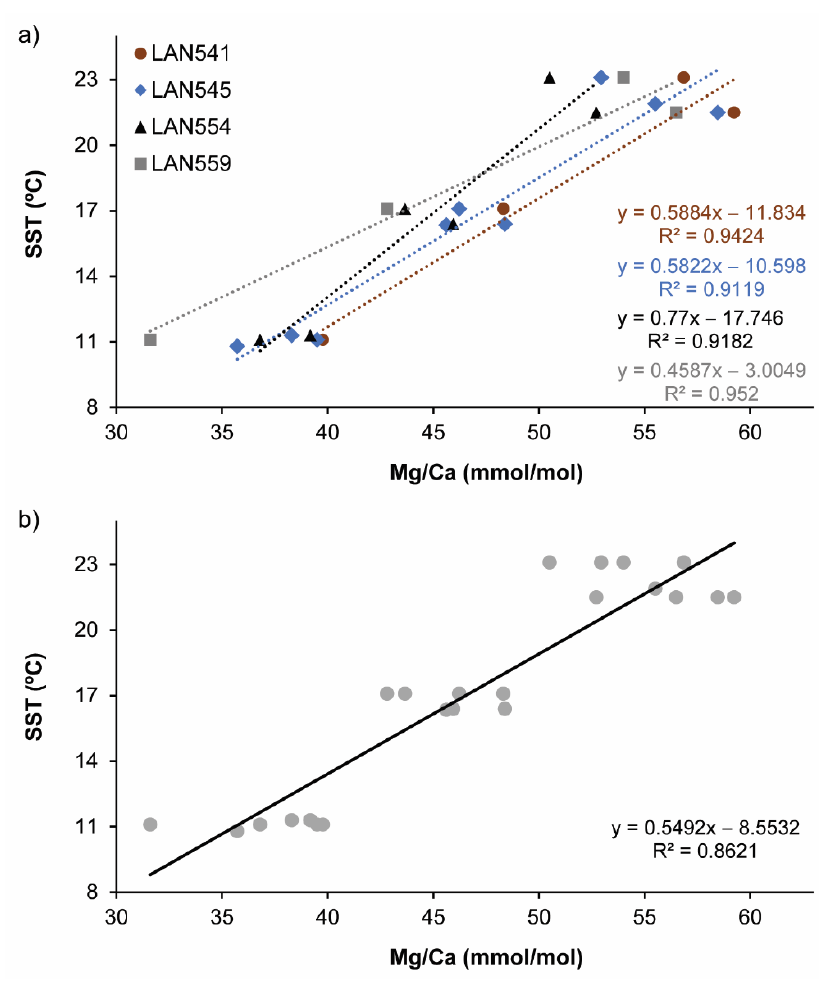
Figure 9. ( a ) Measured minimum, average, and maximum Mg/Ca ratios for each specimen in relation to the minimum, average, and maximum of instrumentally measured seawater temperature. Regression lines and equations, and the correlations, were calculated individually for each sample. ( b ) Measured minimum, average, and maximum Mg/Ca ratios for all specimens in relation to the minimum, average, and maximum of instrumental seawater temperature. The regression lines and equations, and the correlation, were calculated from values obtained from the four samples together.